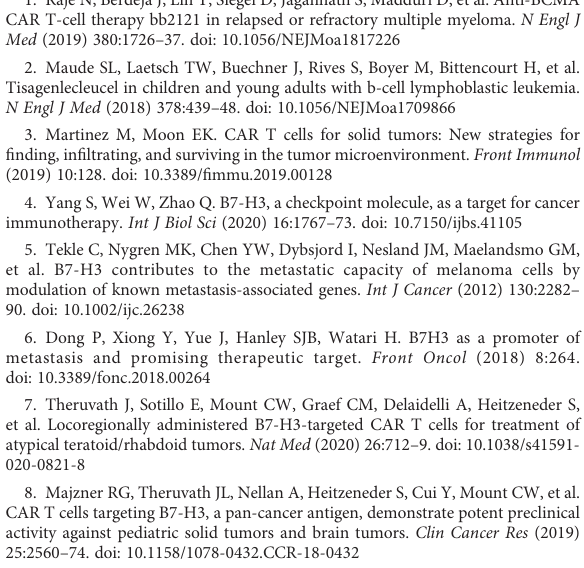
Measurement of blood components before and after the CAR- T